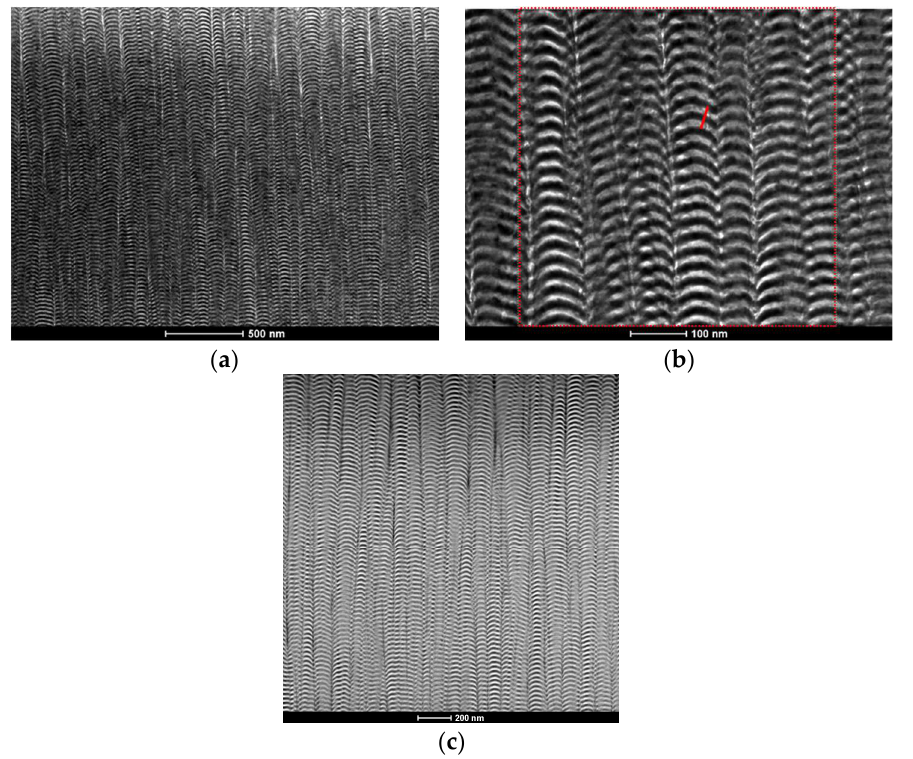
Figure 3. TEM cross-section micrographs of the Al / Ni (V) film with Λ = 25 nm ( V S = − 40 V, ion gun off): ( a ) bright-field (BF) image at lower magnification; ( b ) BF image at higher magnification; ( c ) STEM image.